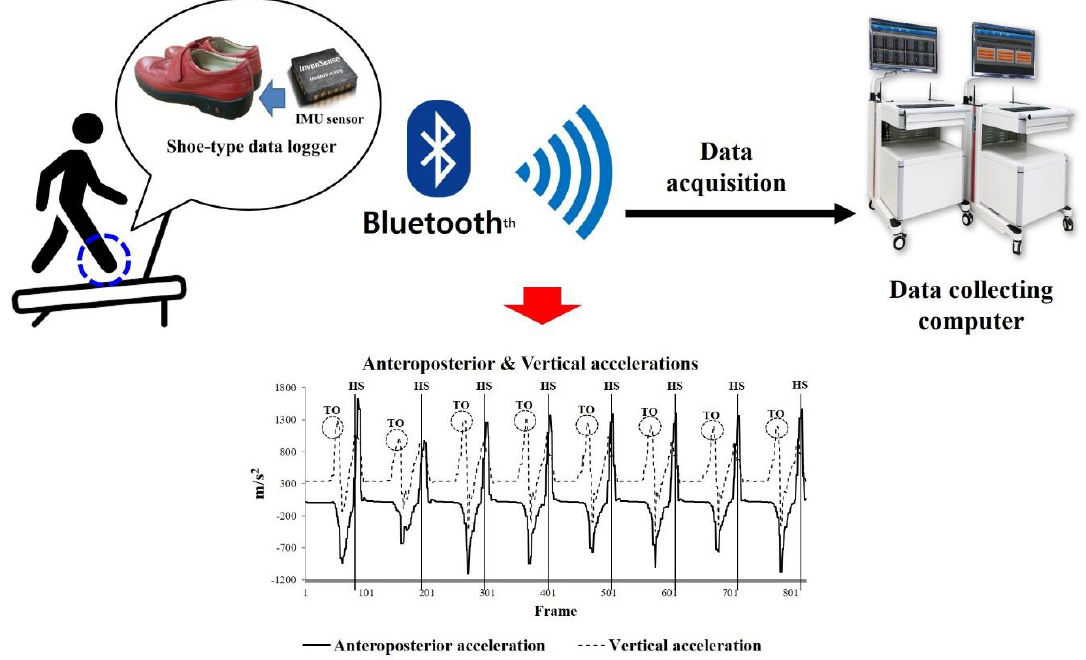
Figure 1. Shoe-type inertial measurement units (IMU) system and detection of gait events (HS is the Heel strike and TO is a Toe off).